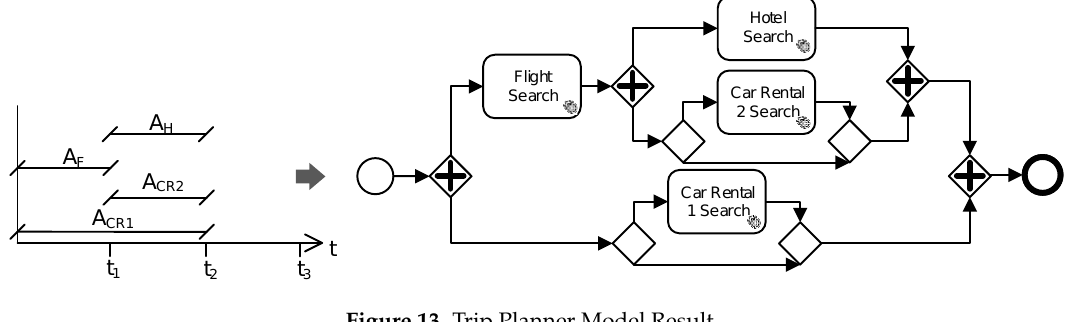
Figure 13. Trip Planner Model